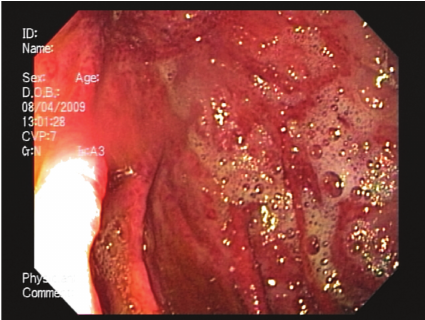
Figure 1: Endoscopic view of the stomach body demonstrating patchy areas of ischemia.